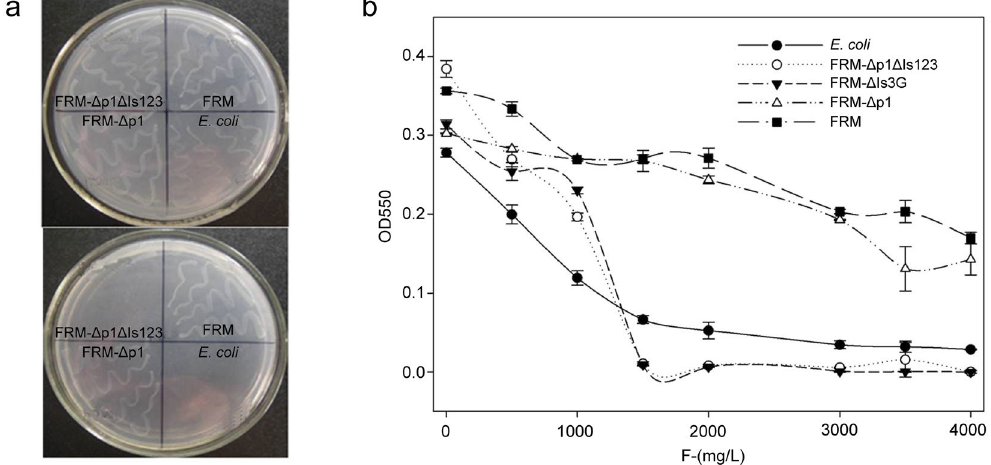
Figure 2. Examination of the fluoride resistance of E . cloacae FRM- Δ p1 Δ Is123 (elimination of plasmid p1 and the three genomic islands) and E . cloacae FRM- Δ p1 (elimination of plasmid p1). ( a ) Four strains were streaked onto Burk plates without fluoride (upper) and with 1,000 mg/L fluoride (lower). ( b ) The minimum inhibitory concentration (MIC) of fluoride for E . cloacae FRM, E . cloacae FRM- Δ p1 Δ Is123, E . cloacae FRM- Δ p1, and E . cloacae FRM- Δ Is3G.